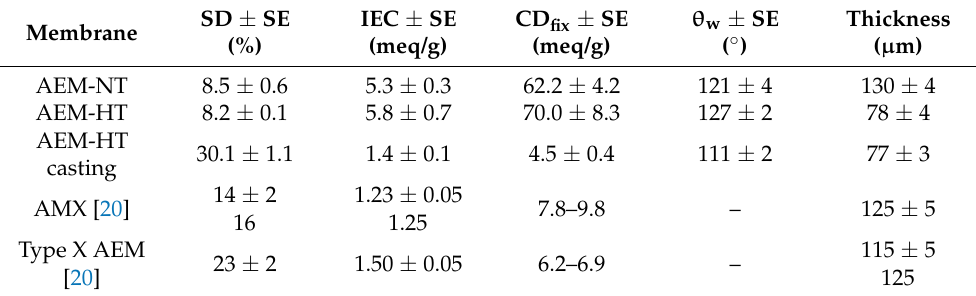
Table 6. Values for swelling degree (SD), ion exchange capacity (IEC), fixed charge density (CD fix ), contact angles ( θ w ) and membrane thickness of the synthesized AEMs, compared to casted and commercial membranes.